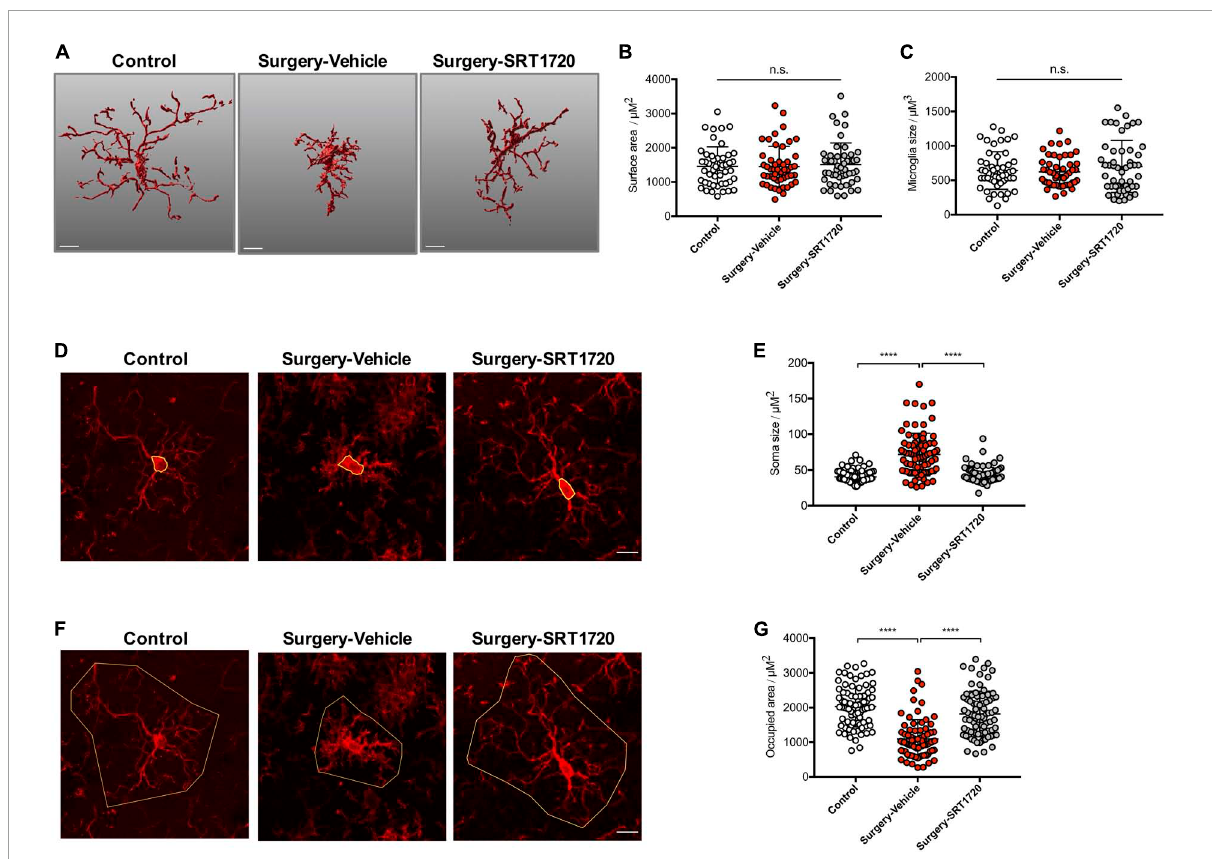
FIGURE4 SIRT1 activation prevents alteration in microglia morphology after anesthesia and surgery. (A) Representative 3D reconstruction and rendering of microglia. Scale bar, 10 µ m. (B) Quantification of surface area of microglia, n = 5 per group; 10 cells per mouse quantified. (C) Quantification of microglia size, n = 5 per group; 10 cells per mouse quantified. (D) Representative images of microglia immunohistochemistry (Iba1, red), with measurement of soma size (yellow outline). Scale bar, 10 µ m. (E) Quantification of microglial soma size, n = 5 per group; 14–18 cells per mouse quantified. (F) Representative images of microglia immunohistochemistry, with measurement of occupied area (yellow outline). Scale bar, 10 µ m. (G) Quantification of microglial occupied area, n = 5 per group; 14–18 cells per mouse quantified. One-way analysis of variance (ANOVA) with Tukey post-hoc test. All data are shown as mean ± SD. n.s., not significant; **** p <